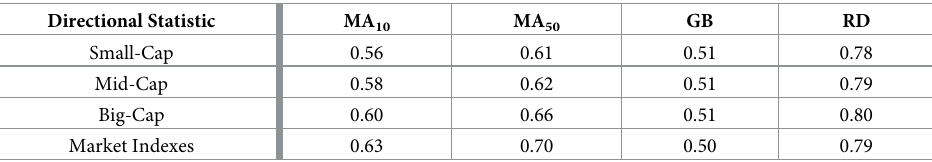
Table 3. Average directional statistics for stocks in different market cap categories ( M =